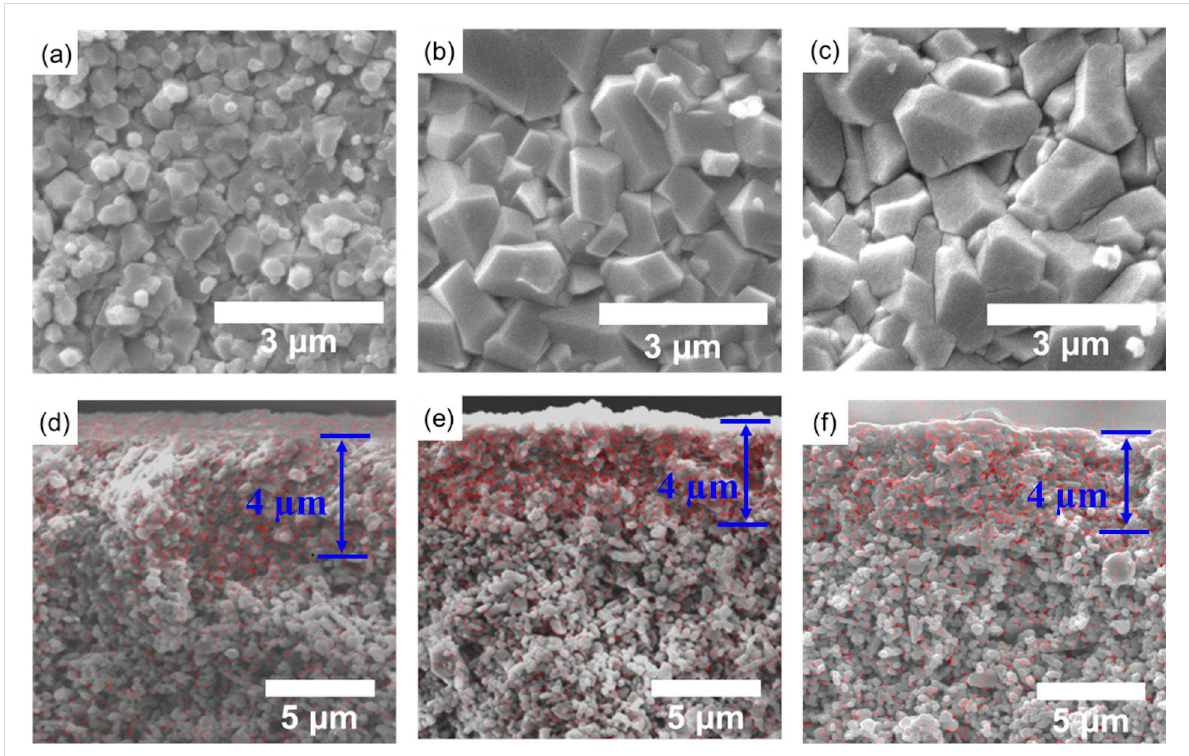
Figure 4: Top-view SEM images of ZIF-8 membranes obtained after (a) 3 h, (b) 12 h, and (c) 15 h at 80 °C. Cross-sectional EDS mappings of ZIF-8 membranes obtained after (d) 3 h, (e) 12 h, and (f) 15 h at 80 °C.